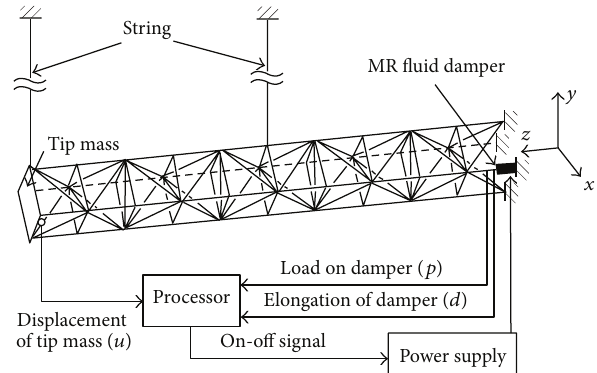
Figure 3: The experimental setup for controlling vibrations of a space truss using MR dampers installed at the root of the structure